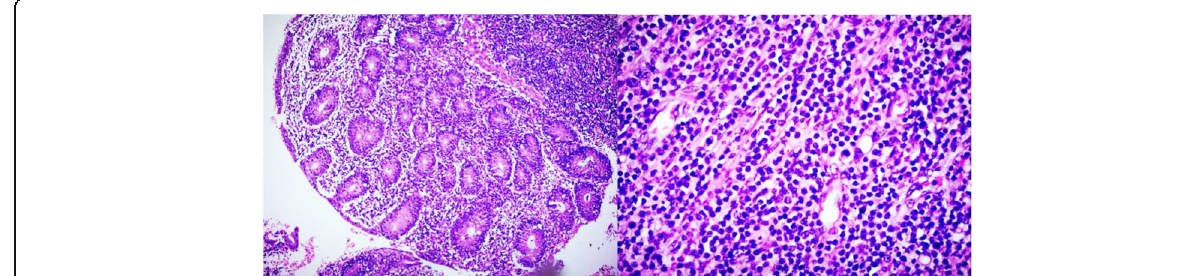
Fig. 2 Histological features of the appendix